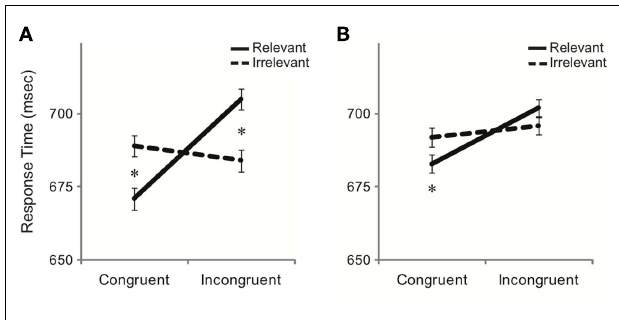
FIGURE 2 | Mean response times by distracter relevance and congruence presented separately for (A) the emotion expression task and (B) the gender task. Error bars represent SE of the